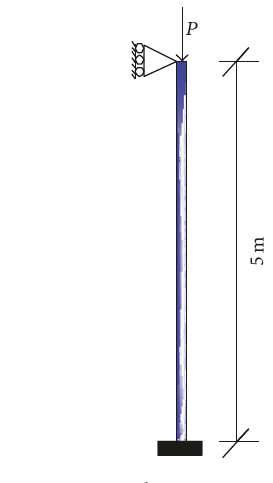
Figure 5: Schematic view of column.